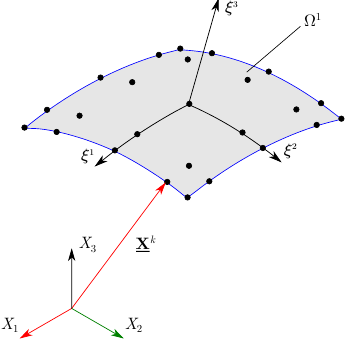
Figure 2. Finite element discretization of shell